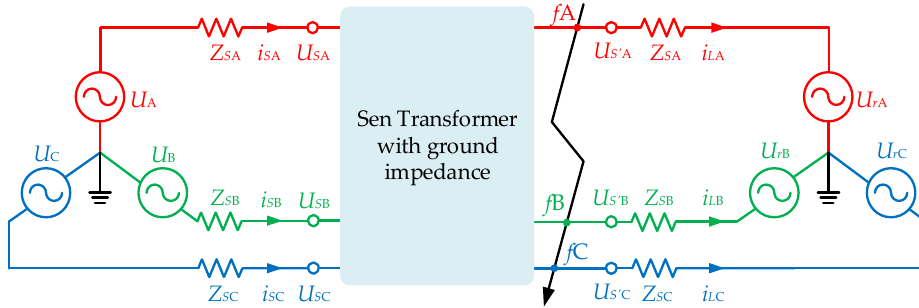
Figure 4. The equivalent circuit diagram for short-circuit analysis.